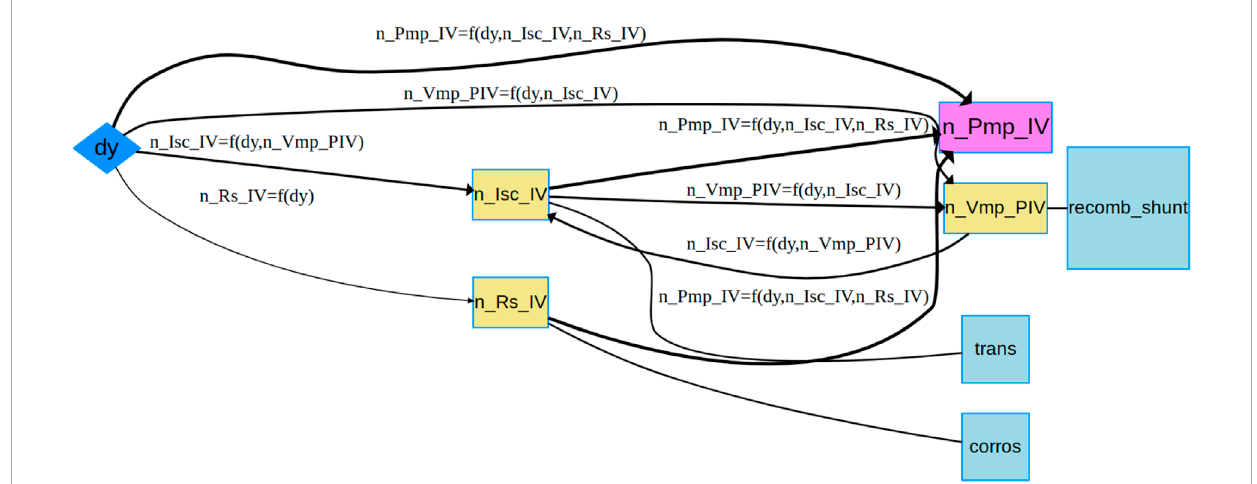
FIGURE 9 < S | M | R > model of GB with EVA by manufacturer B exposed in mDH conditions generated using multiple regression model. dy is exposure time (stressor), n P mp , IV is maximum power, which is the response. n I sc , IV indicates short-circuit current, n R s , IV indicates series resistance and n V mp , PIV indicates voltage at maximum power (IV means that the measurement is from current-voltage data whereas PIV means it is a Suns - V oc measurement). The blue boxes indicate the degradation mode that the variable tracks: n I sc , IV tracks optical transmission loss, n R s , IV monitors corrosion and n V mp , PIV tracks recombination and shunting.